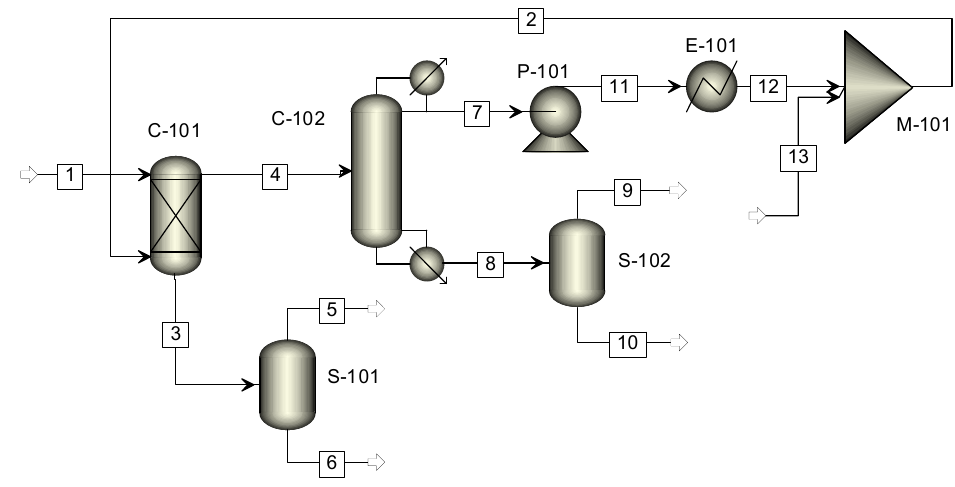
Figure 4. Proposed flowsheet of the SFEE plant.